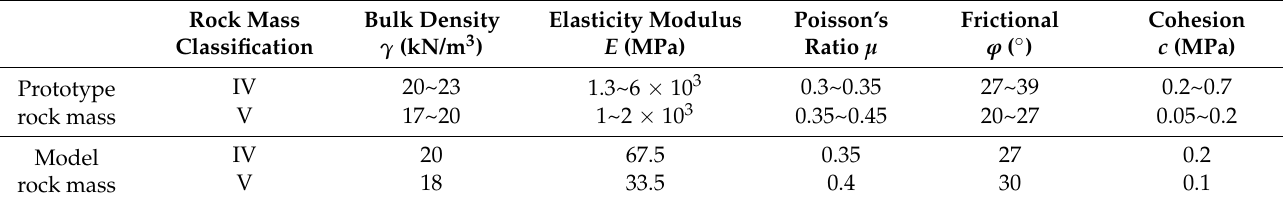
Figure 6. Schematic diagram of the measuring point distribution.